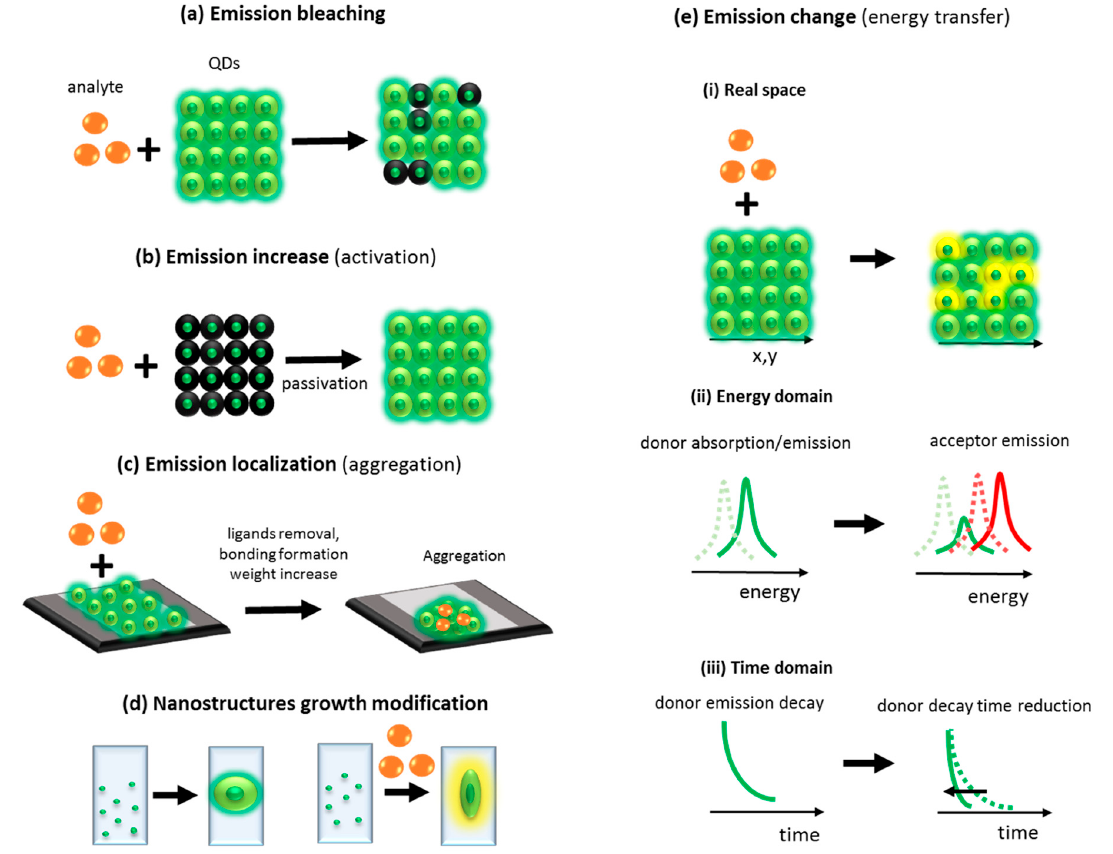
Figure 5. Examples of physico-chemical mechanisms used for analyte optical detection—emission bleaching ( a ), increase of emission ( b ), emission localization ( c ), nanostructures growth’s modification ( d ), emission change ( e ).